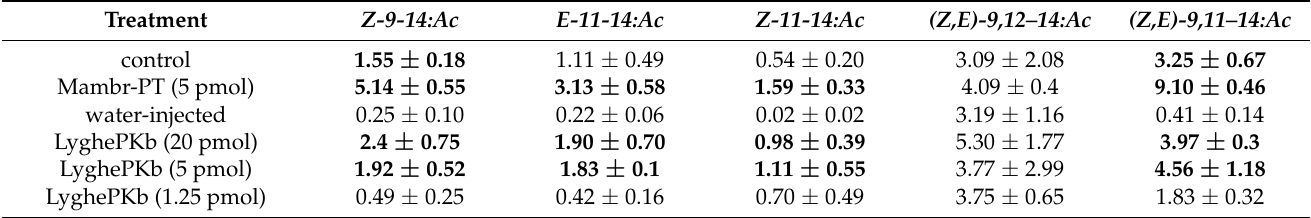
Table 1. Pheromone biosynthesis in adult Spodoptera littoralis